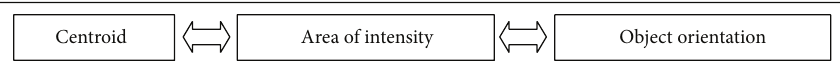
Figure 3: Properties of image moments.